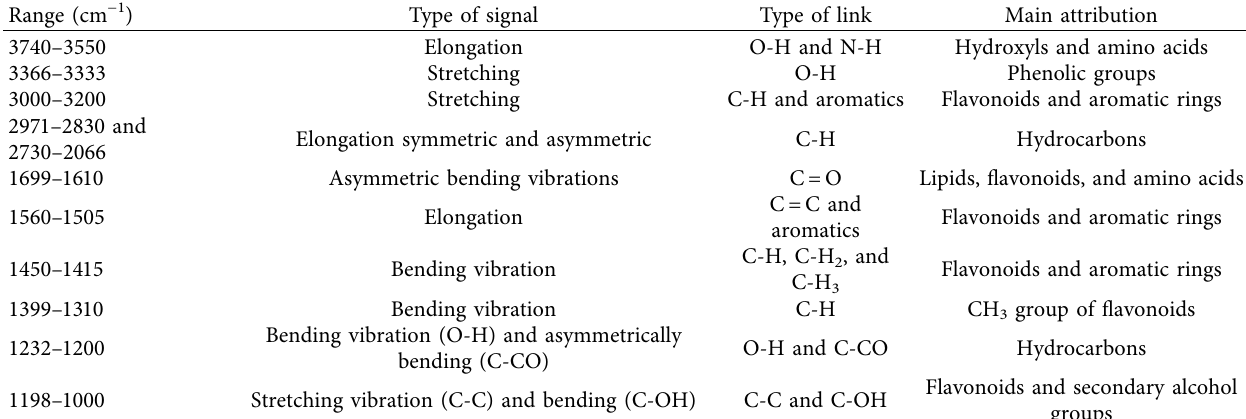
Table 2: Fourier Transform Infrared (FTIR) spectroscopy analysis of propolis